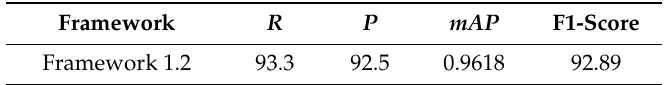
Table 4. R, P, mAP, F1-socre of proposed Framework1.2 on UCAS-AOD